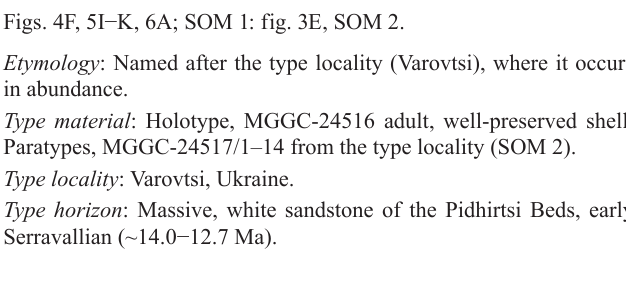
Serravallian (~14.0 − 12.7